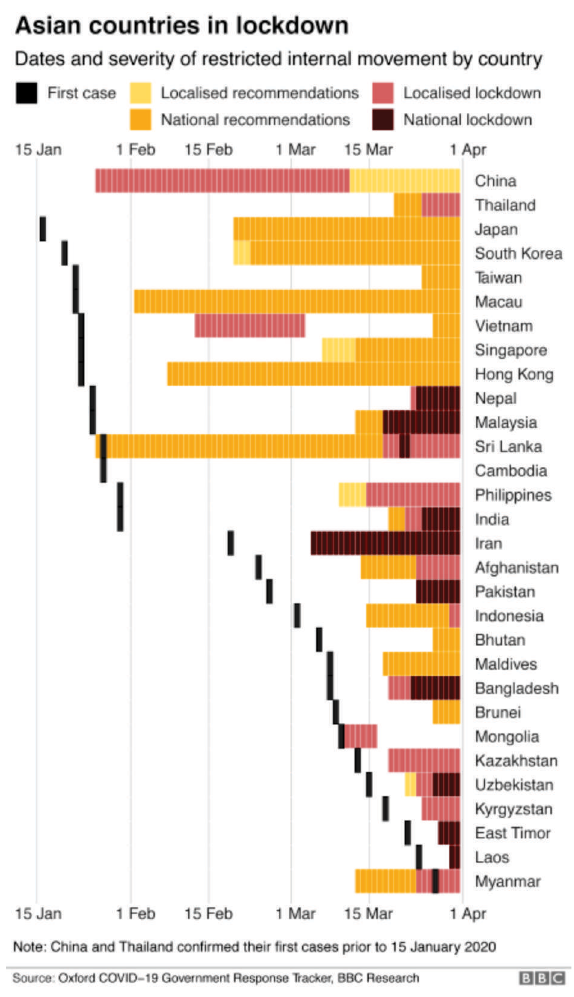
Figure 3: Comparison of the timing of public health strategies implemented in Sri Lanka compared to other